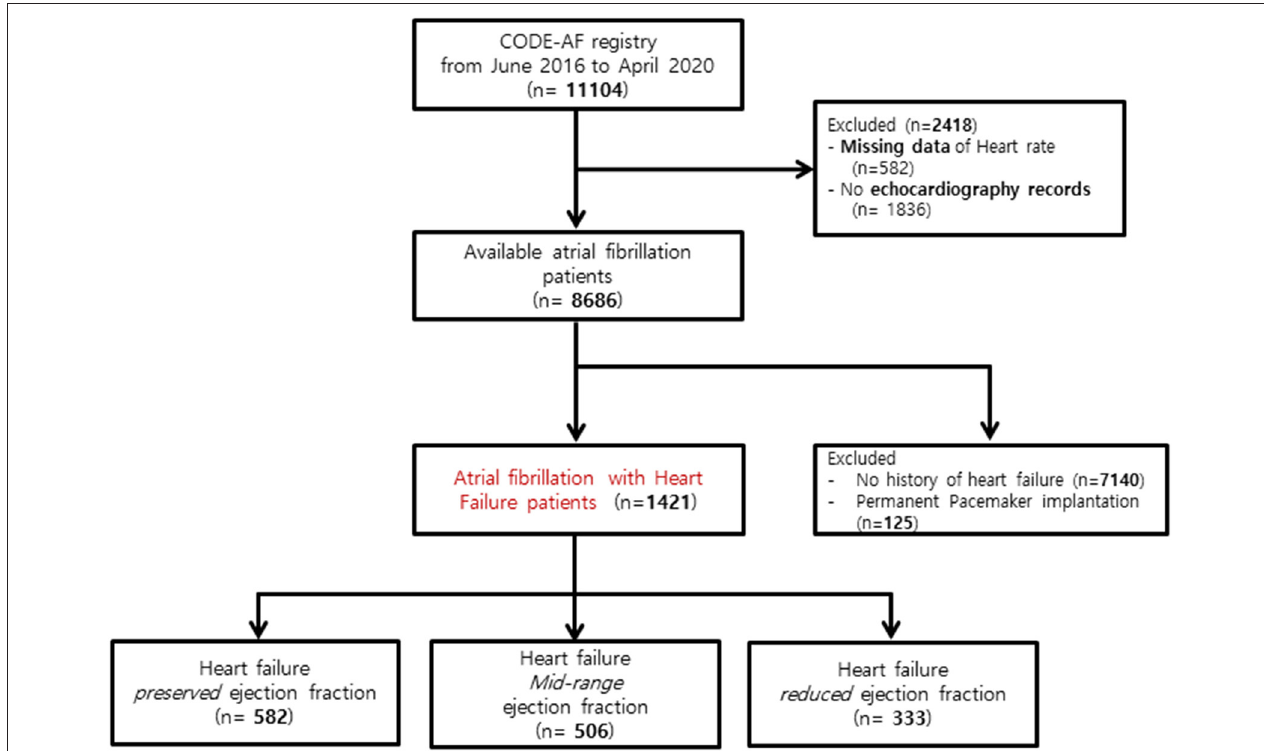
FIGURE 1 | Flowchart of the study population enrollment. CODE-AF, COmparison study of Drugs for symptom control and complication prEvention of Atrial Fibrillation.